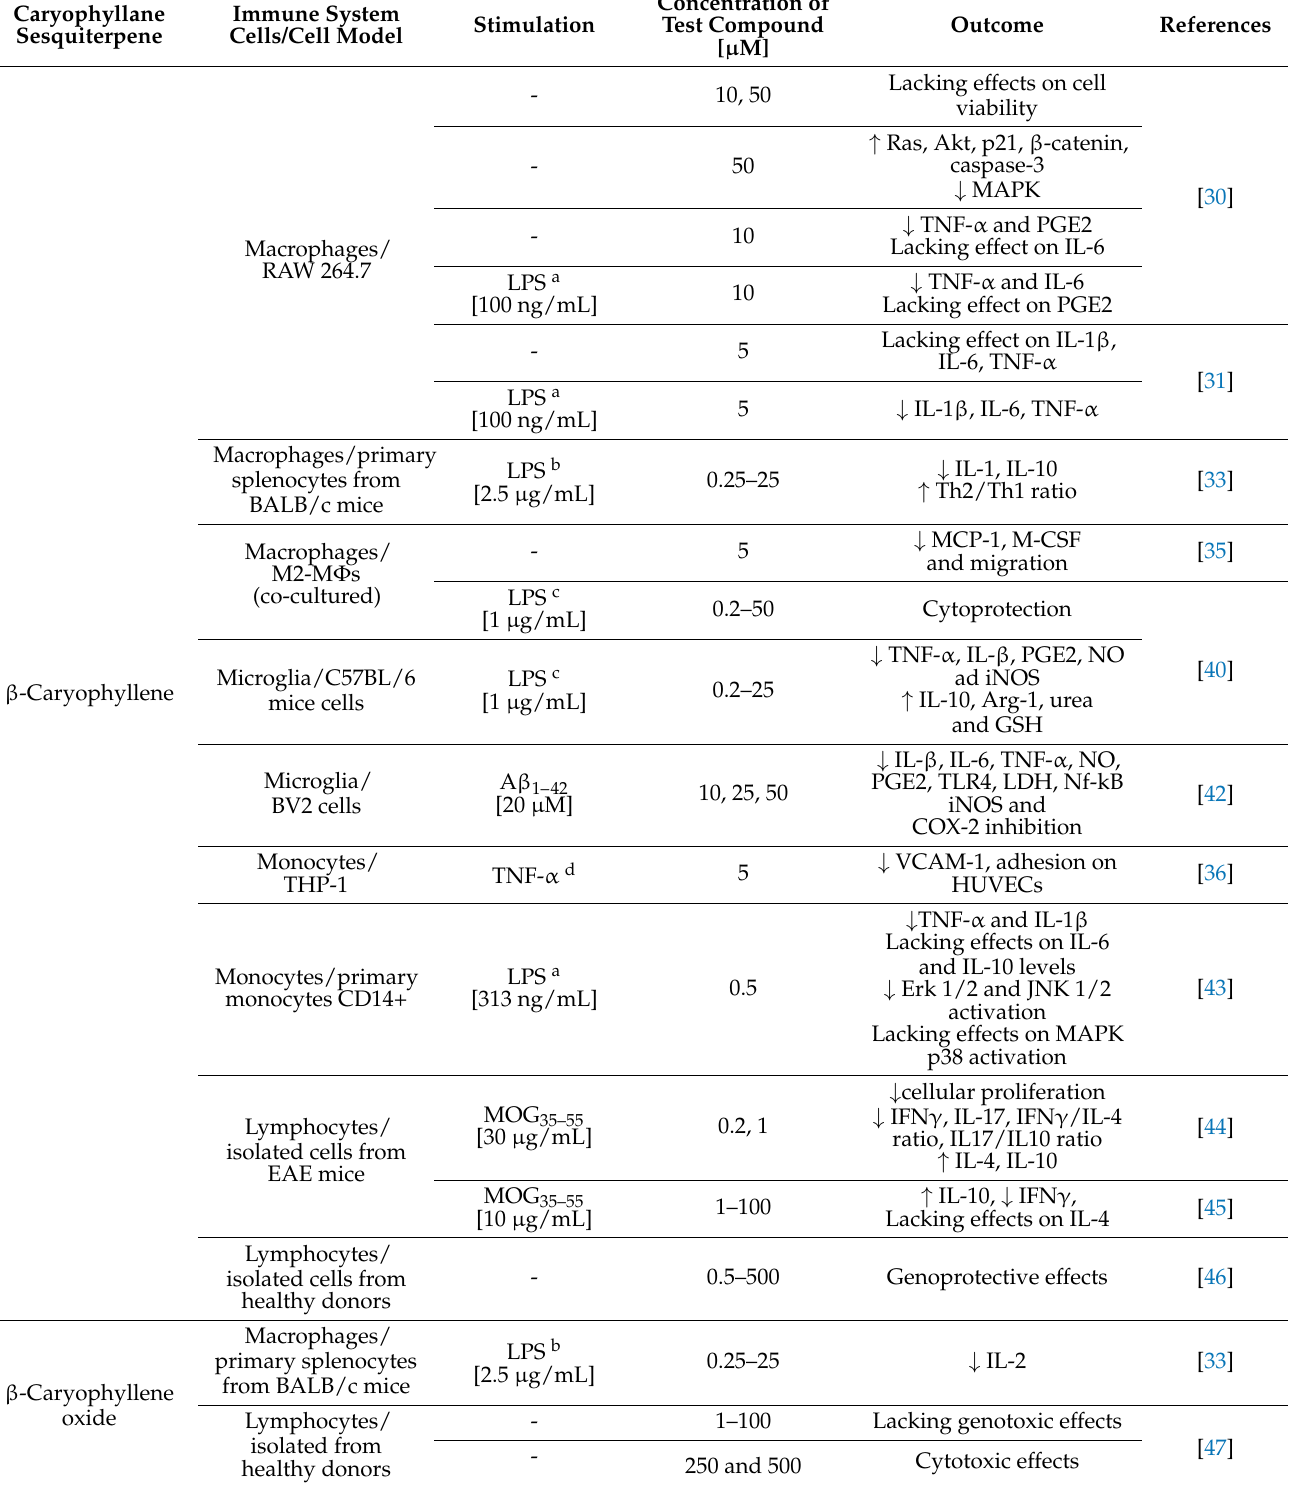
Table 1. Effects of caryophyllane sesquiterpenes in in vitro models of immune cells. Caryophyllane